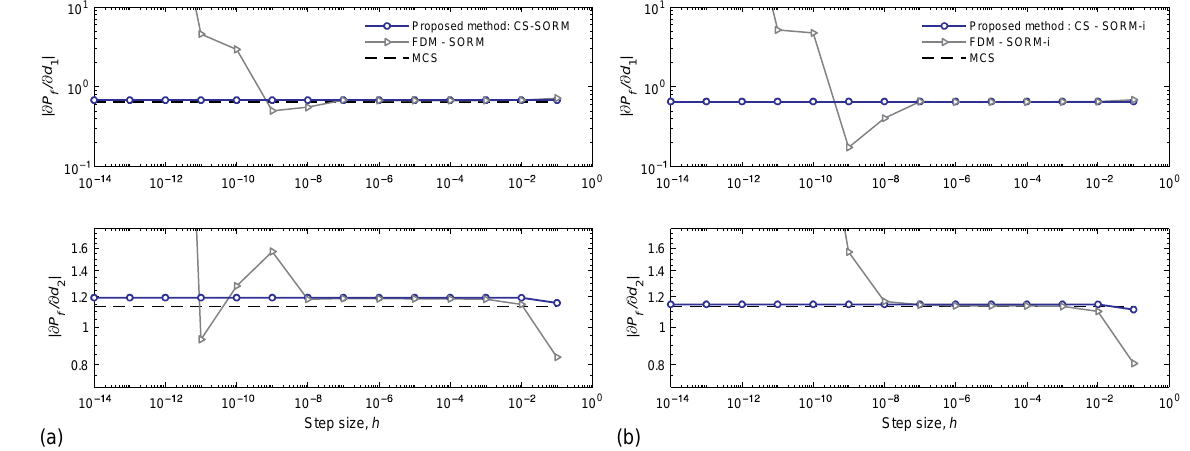
Figure 3. Effect of the step size on the accuracy of the sensitivity analysis performed using the finite difference method (FDM), monte carlo simulation (MCS), and ( a ) CS–SORM and ( b ) CS–SORM-i.